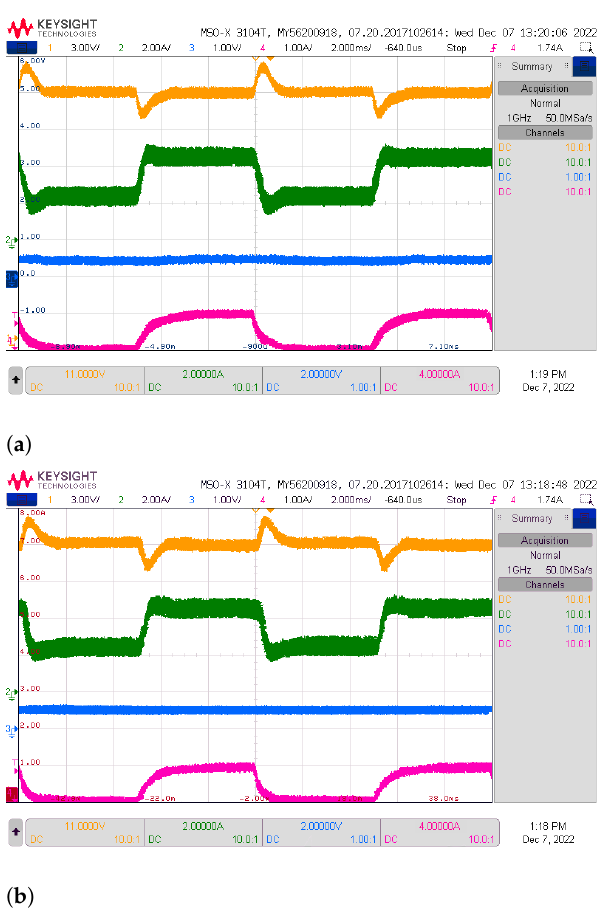
Figure 6. Dynamical response of the proposed controller with and without the estimate ˆ E when the i DC varies in a 100 Hz square waveform between 1 A and 2 A: ( a ) the proposed controller measures the input voltage, and ( b ) the proposed controller uses the estimate ˆ E . CH1: (3 V/div), CH2: (2 A/div), CH3: u (1 /div), and CH4: ˆ i DC (1